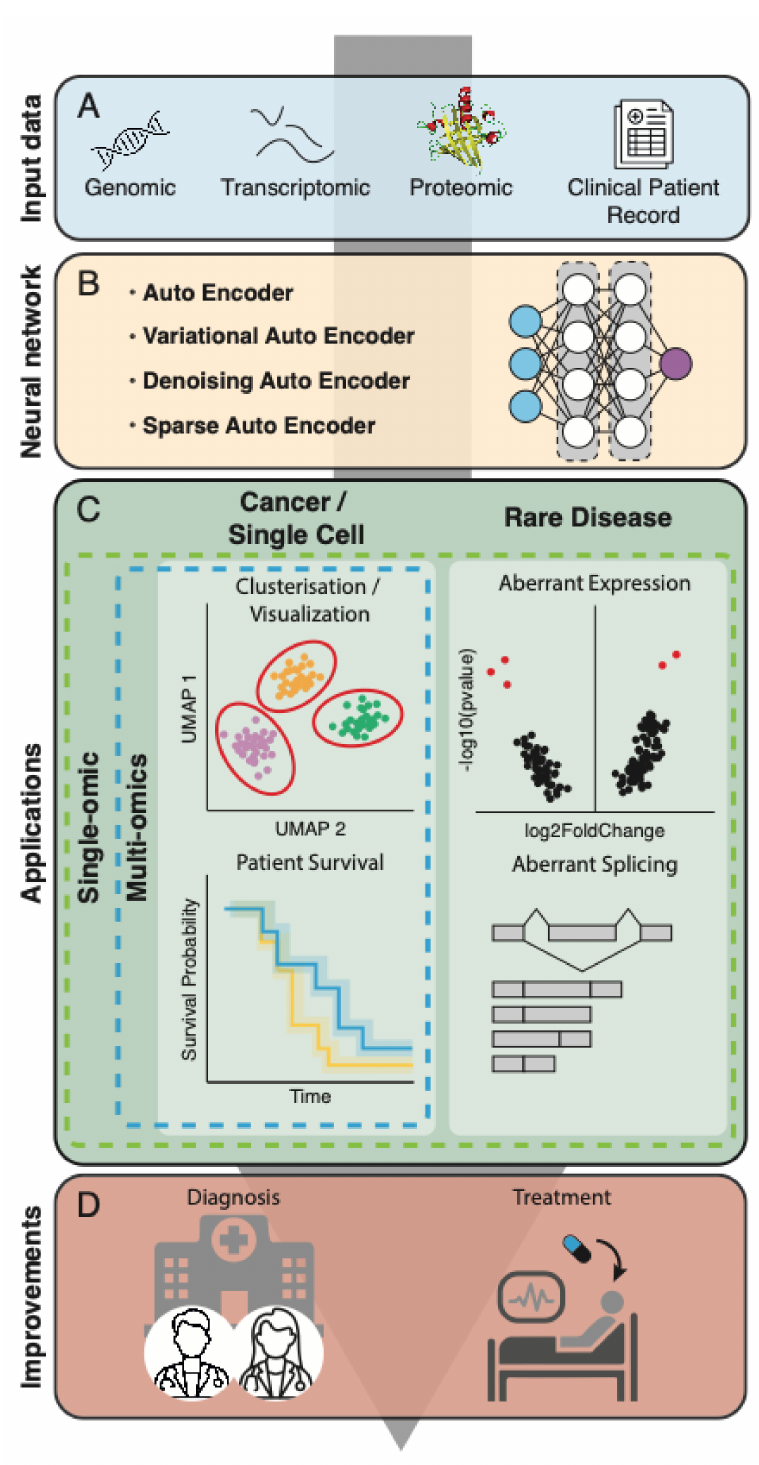
Figure 2. Autoencoders for personalized medicine approaches. ( A )—Input omics data that can be of different types, such as omics, genomics, transcriptomics, proteomics, or clinal patient records. ( B )—An AE-like algorithm is fed by input data as a single data type (single-omic) or multi data (multi-omics). ( C )—Most common applications of these algorithms in the biomedical field and their achievements in terms of data analysis. Green dotted line groups AE applications on single-omic data, whereas blue dotted lines on multi-omics data. ( D )—The results of the previous steps will enable improving patient diagnosis and treatment by providing powerful bioinformatics tools to